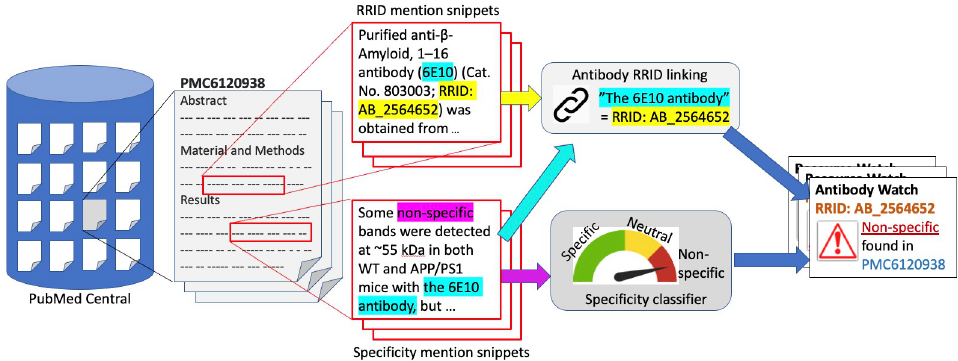
Fig 1. The workflow to construct Antibody Watch. Given the article PMC6120938, a set of “RRID mention snippets” and “Specificity mention snippets” will be extracted. Next, a “Specificity classifier” will determine if a specificity mention snippet states that the antibody, in this case “the 6E10 antibody,” is specific to its target antigen or not. Then, “Antibody RRID linking” will link each specificity snippet to the “RRID mention snippets,” and thus to one or more exact antibodies. In this example, “the 6E10 antibody” is linked to the antibody with “RRID:AB_2564652,” which uniquely identifies an antibody. Finally, an entry is generated and entered into the Antibody Watch knowledge base to alert scientists that this antibody was reported to be nonspecific in PMC6120938 (PMID